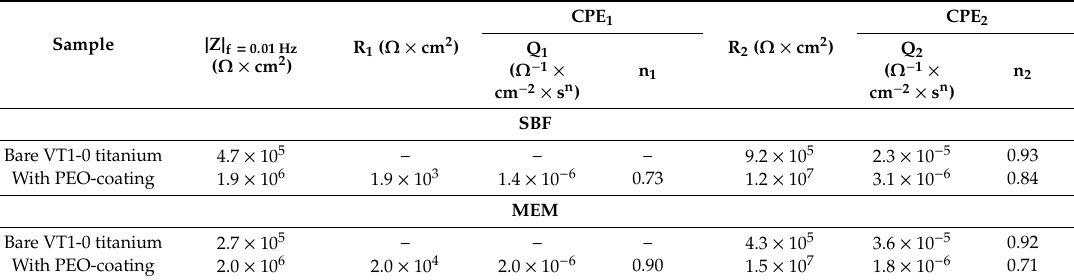
Figure 5. Bode plots (dependence of ( a ) impedance modulus | Z | and ( b ) phase angle θ on frequency f) for uncoated sample and sample with a PEO-coating and equivalent electrical circuits used to fit the experimental impedance spectra: ( c ) one–R–CPE–circuit, ( d ) two–R–CPE–circuit. Impedance spectra contain experimental data (scatter plot marked by symbols) and theoretical fitting curves (lines), which simulate the experimental results by means equivalent electrical circuits. Test liquid is SBF. Table 5. Calculated parameters of equivalent electrical circuits for samples with di ff erent types of surface